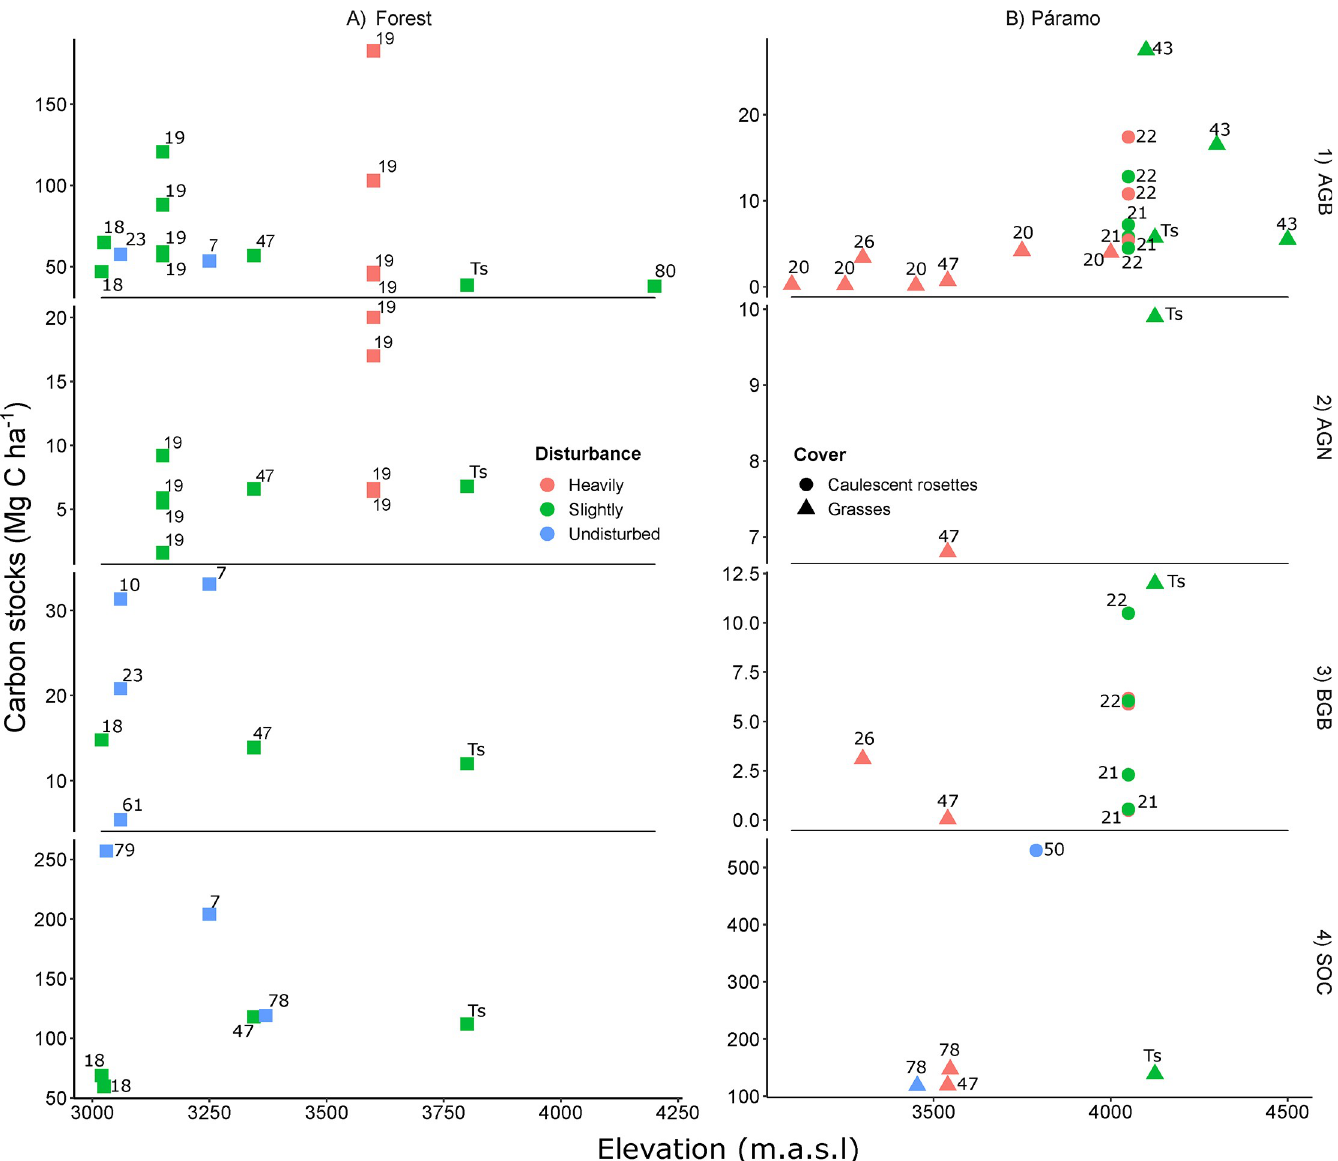
Fig 8. C stocks comparison among published studies in high Andean ecosystems for forest (a) and pa´ramo (b) ecosystems. Reported values by C pool, AGB (1), AGN (2), BGB (3) and AGN (4) have been categorized according to the reported site degradation status: undisturbed (blue fill), slightly (green fill) and heavily disturbed (red fill) sites. In addition, for the pa´ramo sites we have included their reported growth-form cover: caulescent rosettes (circles) and grasses (triangles). Sites in forest ecosystems are represented as squares. The number besides each observation is the reference to the study where ‘Ts’ refers to this